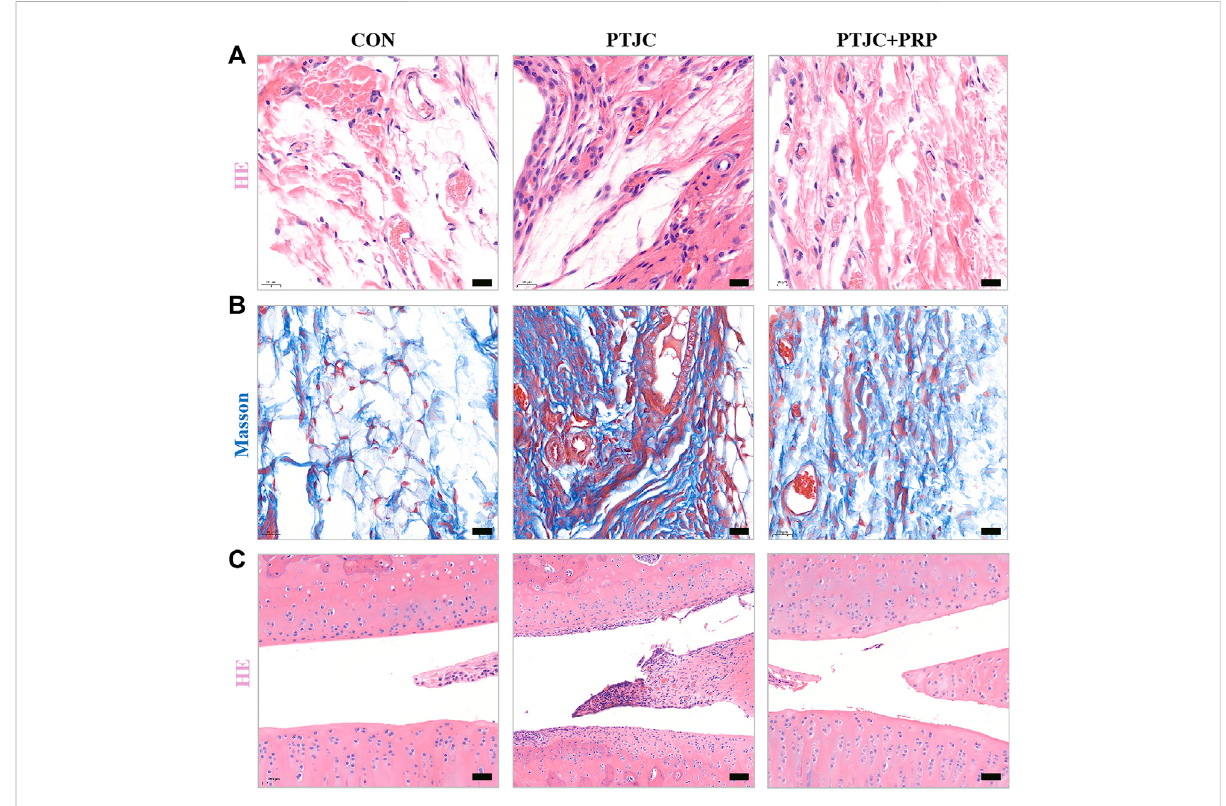
FIGURE 7 HE and Masson staining of the affected knee. (A,B) HE (A) and Masson (B) staining of the posterior joint capsule of the affected knee. (C) HE staining of articular cartilage surface. Scale bars, 50 μ